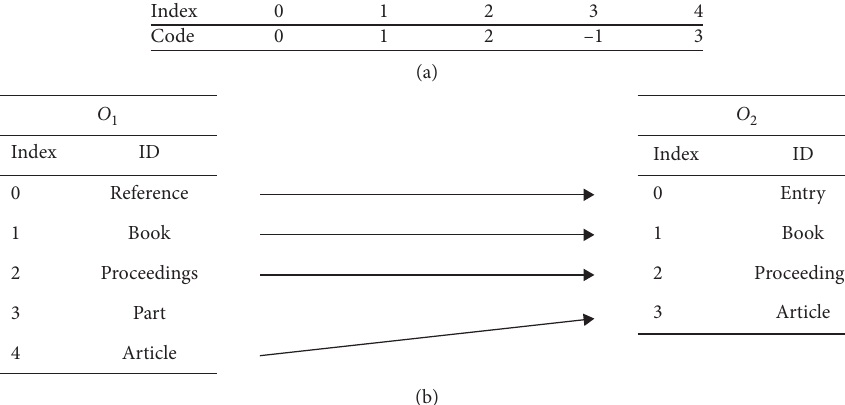
Figure 5: An example of chromosome.